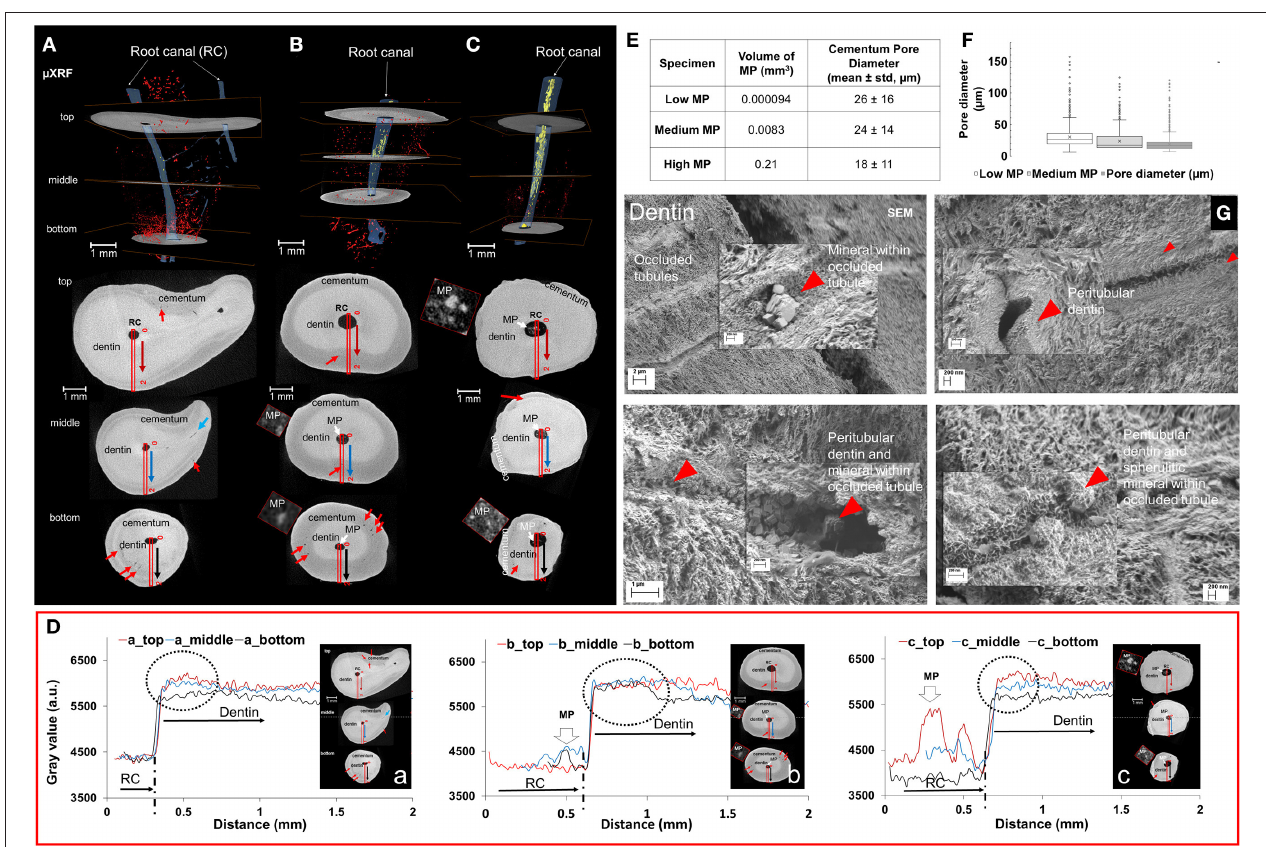
FIGURE 2 | Mineralizing tooth roots with decreased cementum and dentin porosities also contained pulp with higher mineral density. Root canals (blue), mineralizing pulp (white) (A–C) , and pores in cementum (red) with three X-ray slices (top, middle, bottom) from different roots (A–C) show the spatial relation between root canal system with mineralizing/mineralized pulp. Mineral density plot profiles from root canal to cementum expressed in gray scale illustrated higher mineral density regions (dotted circle, D ) adjacent to the root canal, and various mineral density distributions and cementum thicknesses for different roots (D) . More lateral root canals and pores in cementum (red arrows in X-ray tomograms/top, middle and bottom sections) were observed in less mineralized pulp (E,F) . Tubules in dentin with nano/micro-mineralized occlusions (red arrowhead) were found adjacent to mineralizing pulp (G)